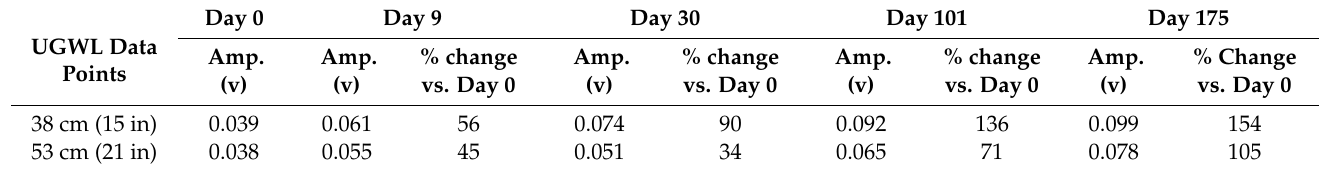
Figure 7. Specimen A: UGWL amplitude change for two sensor points over 175 days. Table 3. Change of amplitude for various points for Specimen